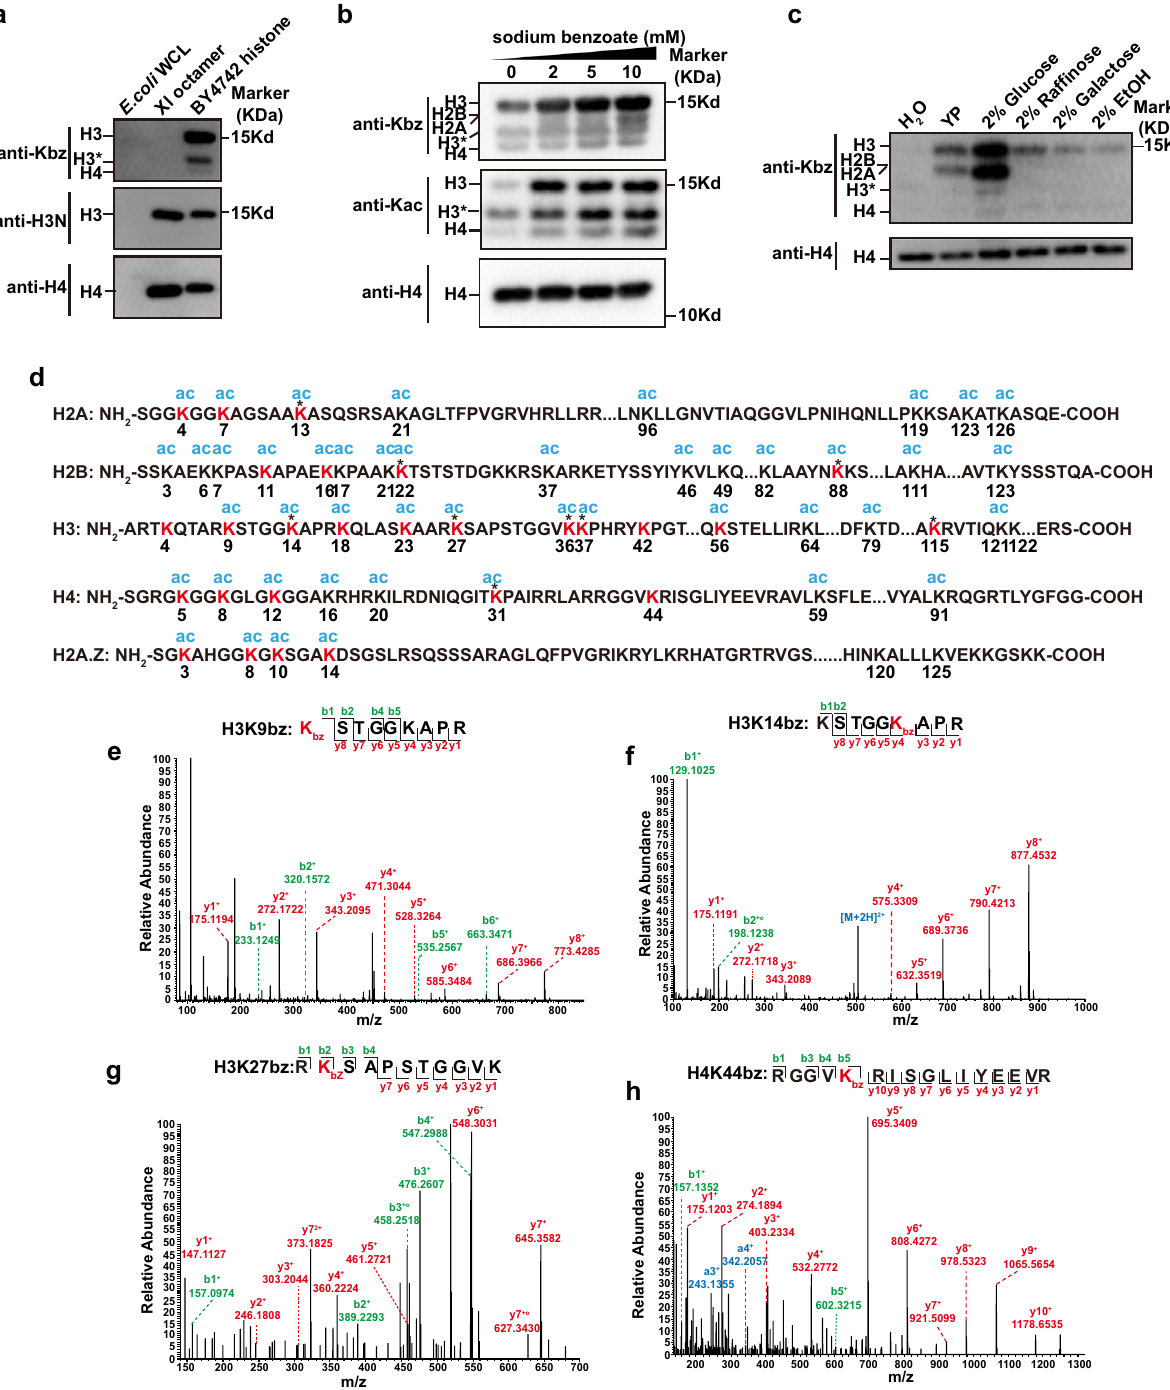
Fig. 1 Identi fi cation of histone Kbz in yeast. a Detection of the Kbz signals from core histones extracted from BY4742 yeast cells. The speci fi city of pan anti-Kbz was con fi rmed because it did not recognize any band from the E.coli whole-cell lysate ( E.coli WCL) or recombinant Xenopus laevis histone octamer (Xl octamer) puri fi ed from E.coli . The H3* represents clipping H3. Source data for panels a – c are provided in the Source Data fi le. b Sodium benzoate treatment signi fi cantly enhanced the Kbz and Kac levels on yeast histones in a dose-dependent manner. BY4742 cells were grown in YPD to log phase, and then sodium benzoate was added into the medium for 6 h, followed by extraction of histones and western blotting analysis. c The level of histone Kbz was regulated by the type of carbohydrate. BY4742 cells were grown in standard medium with 2% glucose to log phase and then transferred to H 2 O or other indicated mediums for 4 h, followed by extraction of histones and western blotting analysis. d Illustrations of all Kbz sites identi fi ed on core histones extracted from yeast cells treated with 10 mM sodium benzoate. The detected Kbz sites are shown in red. Nine Kbz sites detected in samples without sodium benzoate treatment are labeled by asterisks. Most Kbz sites overlap with the known Kac sites, except for H3K42, H3K115, and H4K44. e – h : MS/MS spectra of H3 and H4 peptides bearing Kbz modi fi cation. ( e ) H3K9; ( f ) H3K14; ( g ) H3K27; ( h ) H4K44. Predicted b- and y-type ions are listed above and below the peptide sequence, respectively. The circle symbol indicates the neutral loss of water. Matched ions are labeled in the